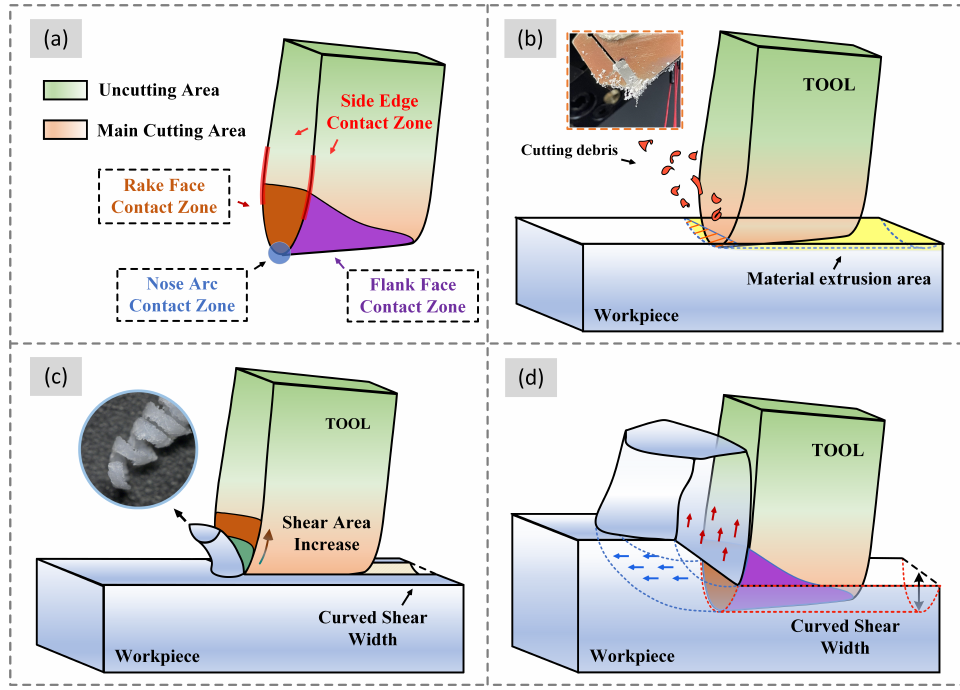
Figure 3. Shear behavior and chip outflow in different stages of grooving: ( a ) different contact areas of the tool at ( b ) Stage I; ( c ) Stage II; and ( d ) Stage III.